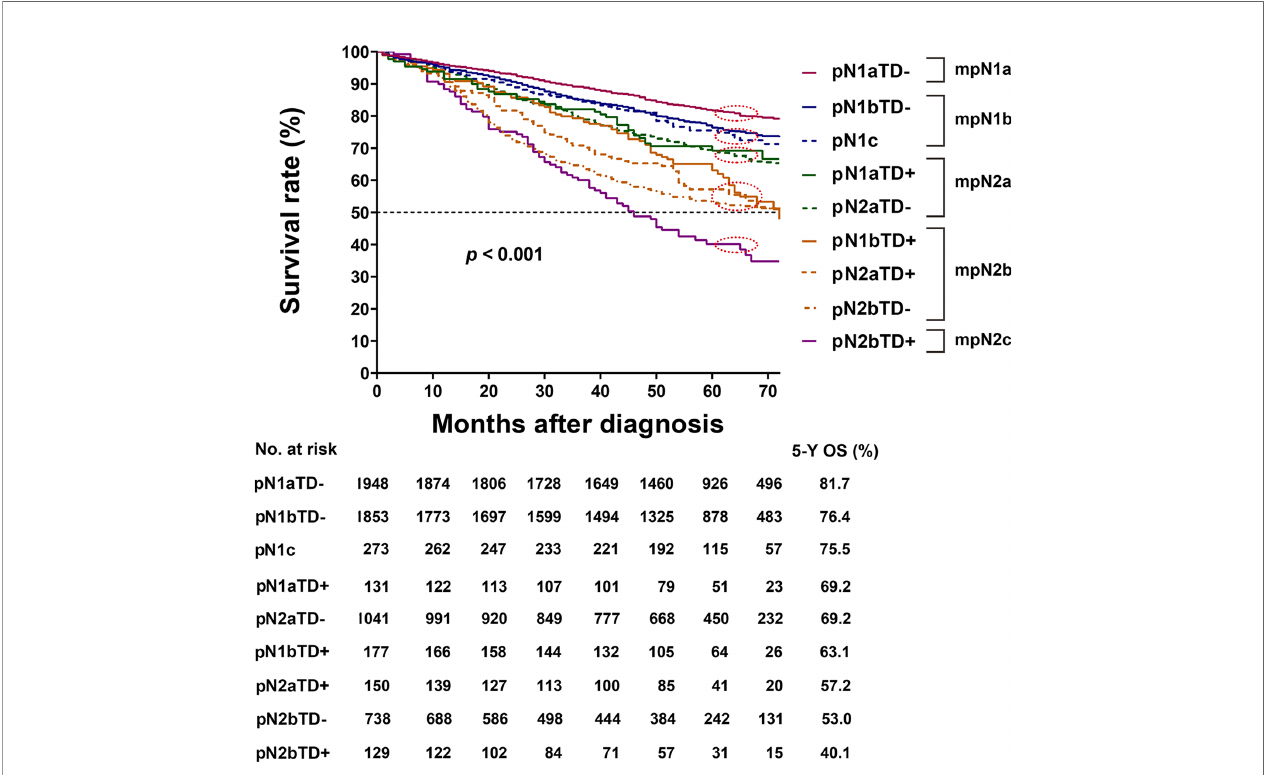
FIGURE 3 | Kaplan – Meier survival curves for pathological N (pN) stage based on the presence or absence of tumor deposits (TDs) in patients in the training cohort.